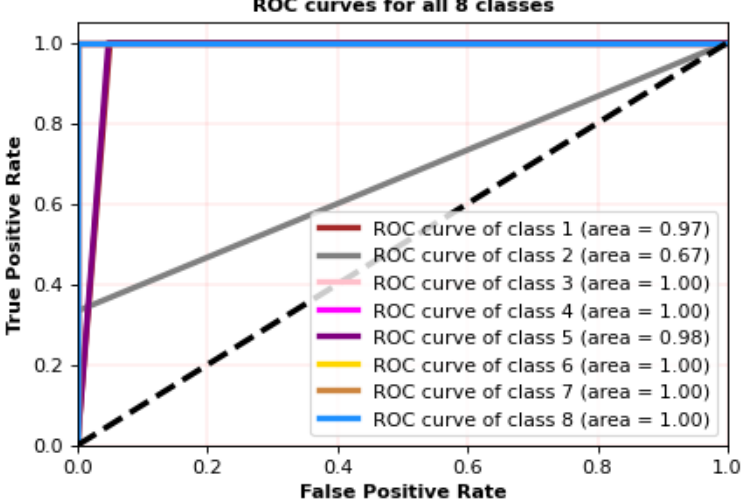
Figure 10. Real-World HAR: individual ROC curves for all the classes, class 1 = stairs-up, class 2 = stairs-down, class 3 = jumping, class 4 = lying, class 5 = running, class 6 = sitting, class 7 = standing, class 8 = walking.